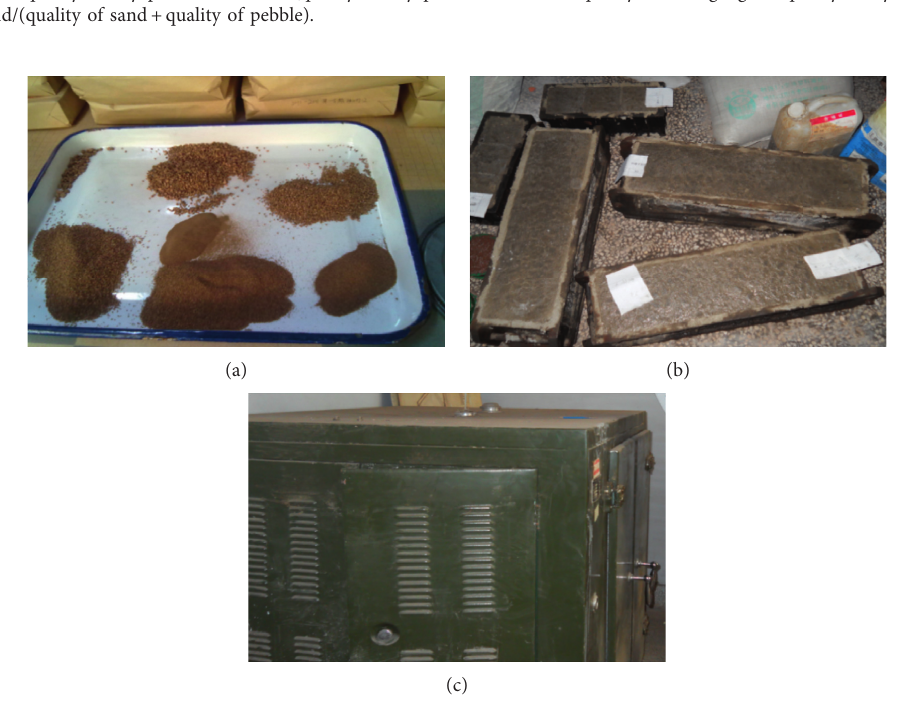
Figure 1: Production process of test blocks. (a) Raw materials for the experiment. (b) Coal gangue-based geopolymer concrete blocks. (c) Oven